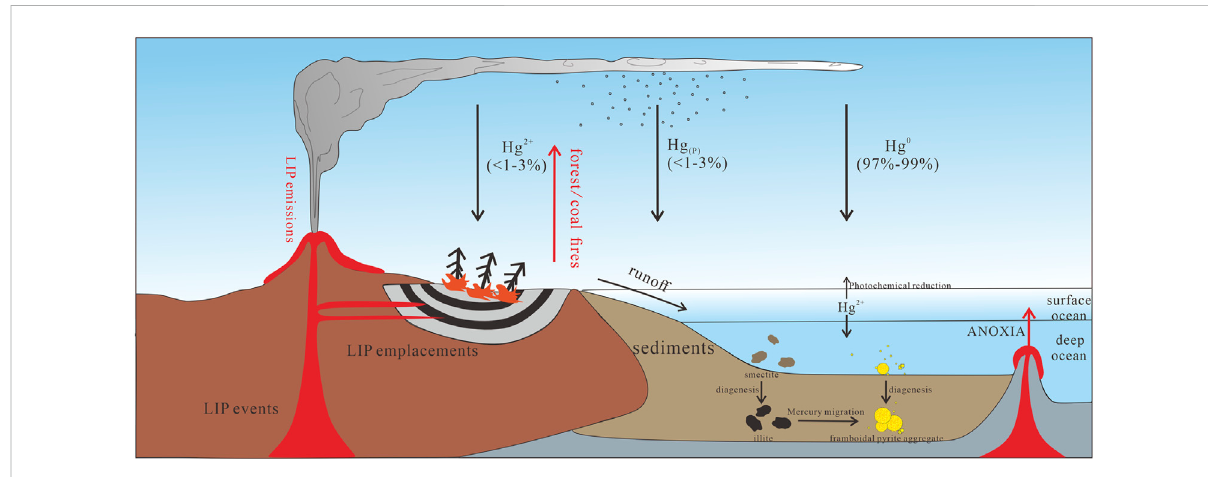
FIGURE 1 Circulation, transport and form of mercury in nature (modi fi ed from Percival et al.,